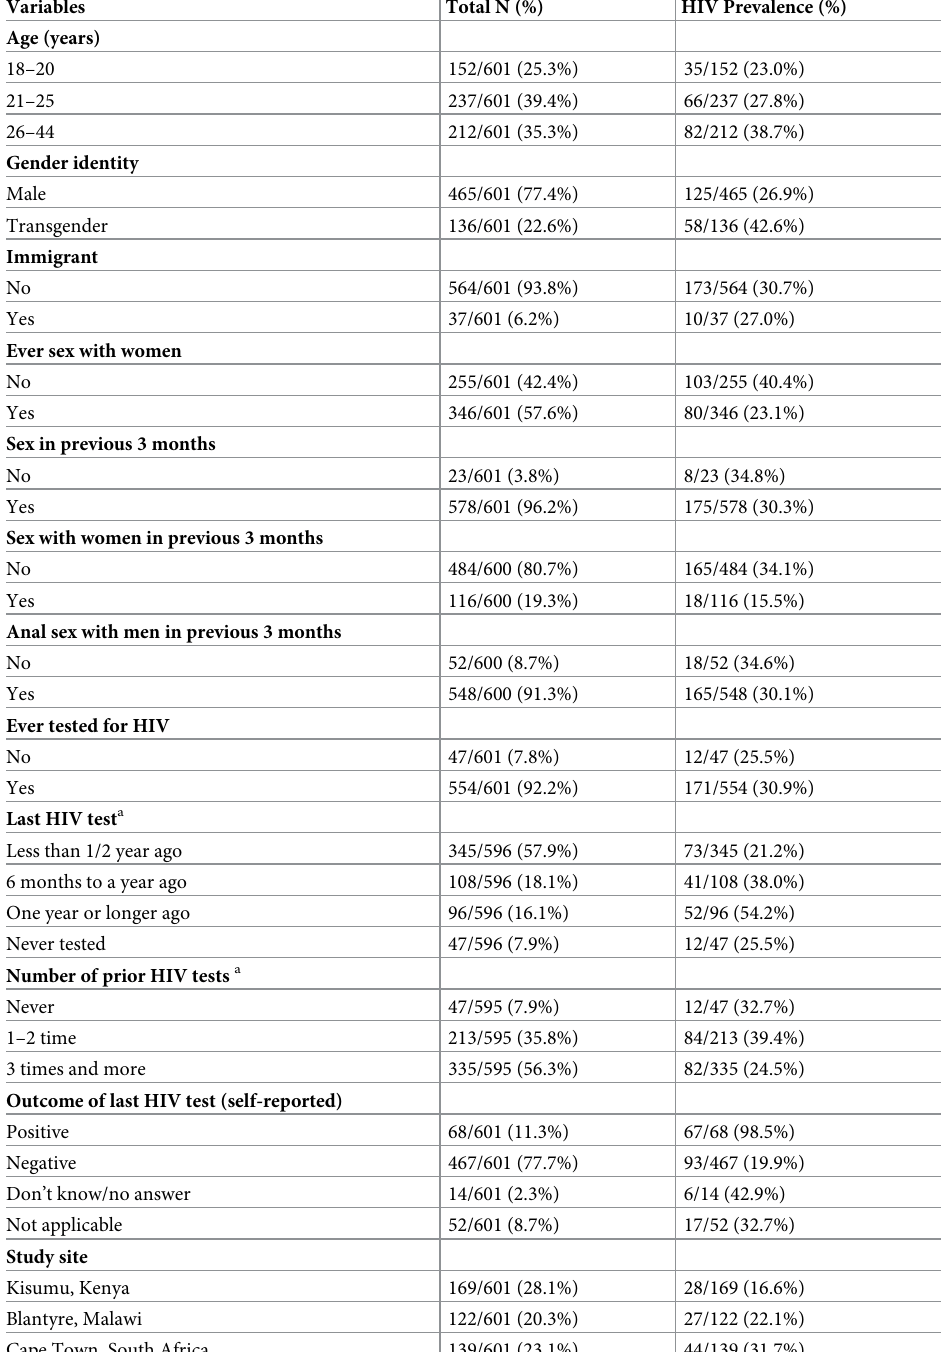
Table 1. Characteristics of MSM and TW screened for participation in HPTN 075 (N =